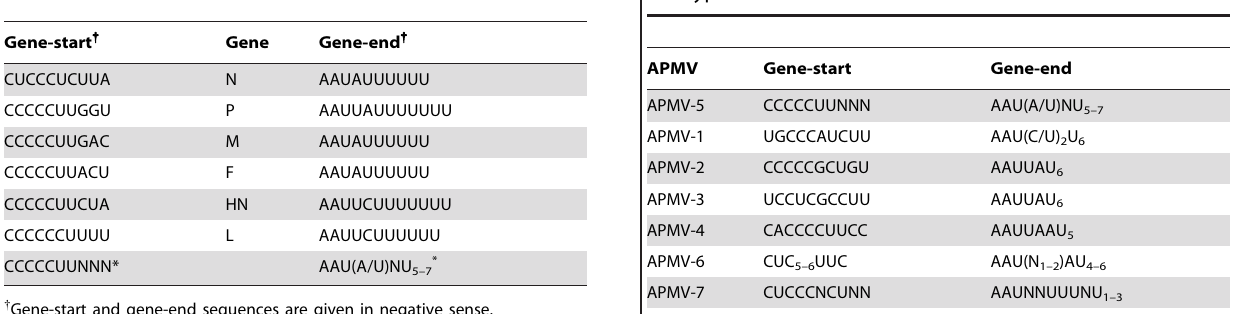
Table 3. The consensus sequences of the gene-start and gene-end signals of prototypes strains of the nine APMV serotypes { .